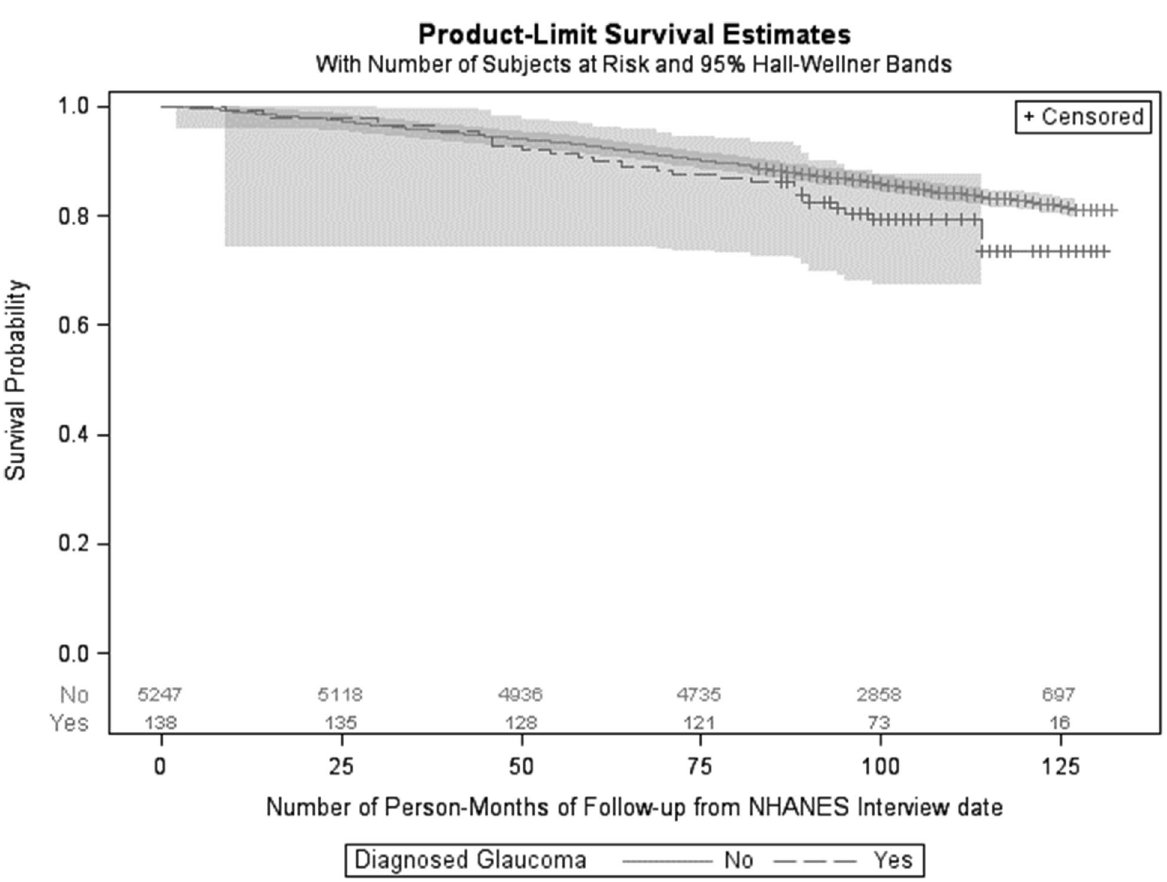
Figure 1. Product limit survival estimates for study participants with and without glaucoma. The grey areas depict 95% Hall–Wellner Bands. Numbers of participants at risk are shown above the mobile examination center. The NHANES survey cycles 2005–2006 and 2007–2008 included both ophthalmic examinations and retinal imaging of all participants aged 40 years and older. Our statistical analyses are based on